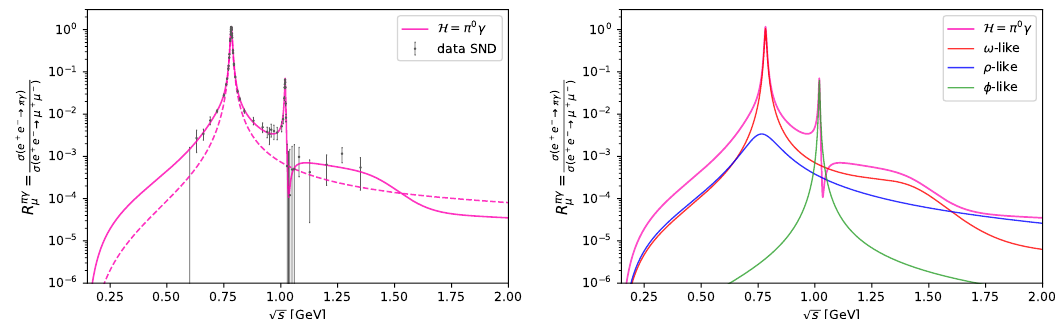
for the H = π 0 γ channel. In the left panel the Figure 16 . Normalized cross-section R H µ solid (dashed) pink line indicates our ( DarkCast ) calculation, and the gray data points are from SND [38]. In the right panel we show our decomposition of the πγ channel into ρ (blue), ω (red) and φ (green) components.